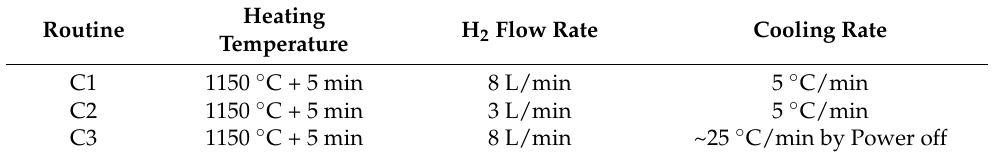
Table 2. Processing parameters of final transformation treatments for 1# and 2# samples.